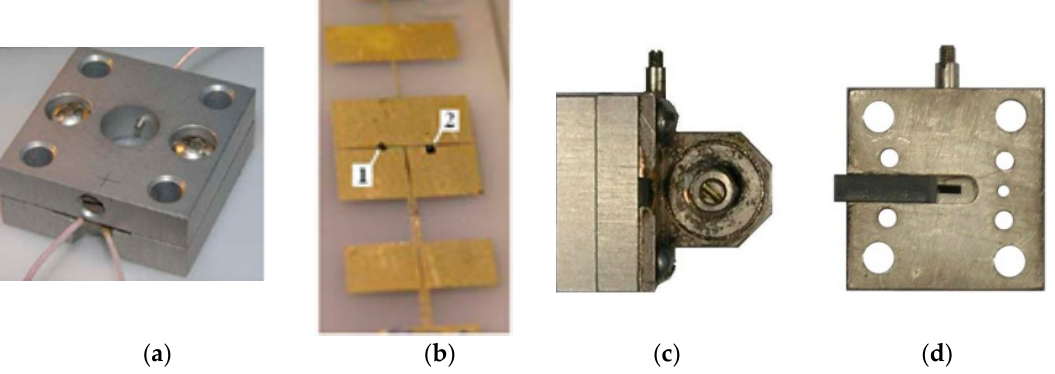
Figure 9. ( a ) External view of the Tigel-08 М module, ( b ) topology of the diode insertion, ( c ) the oscillator with the stabilizing resonator and ( d ) the element of the resistor coupling with the